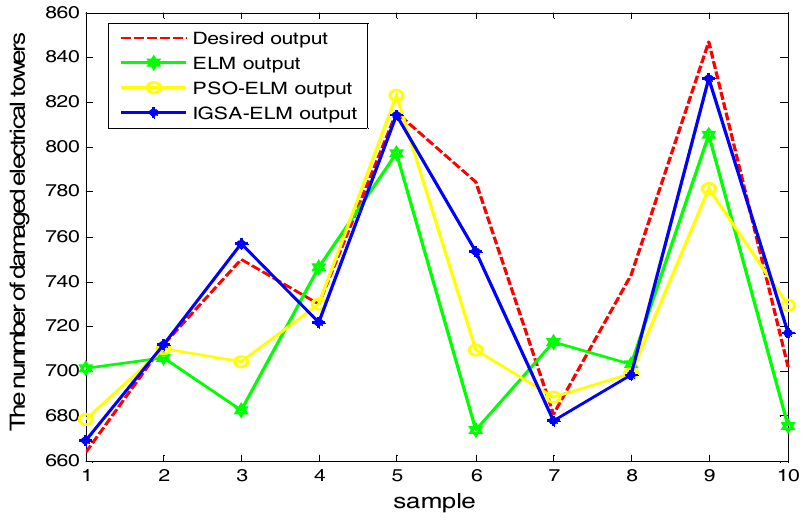
Figure 3. Fitting curves of the ten predictions and desired output.